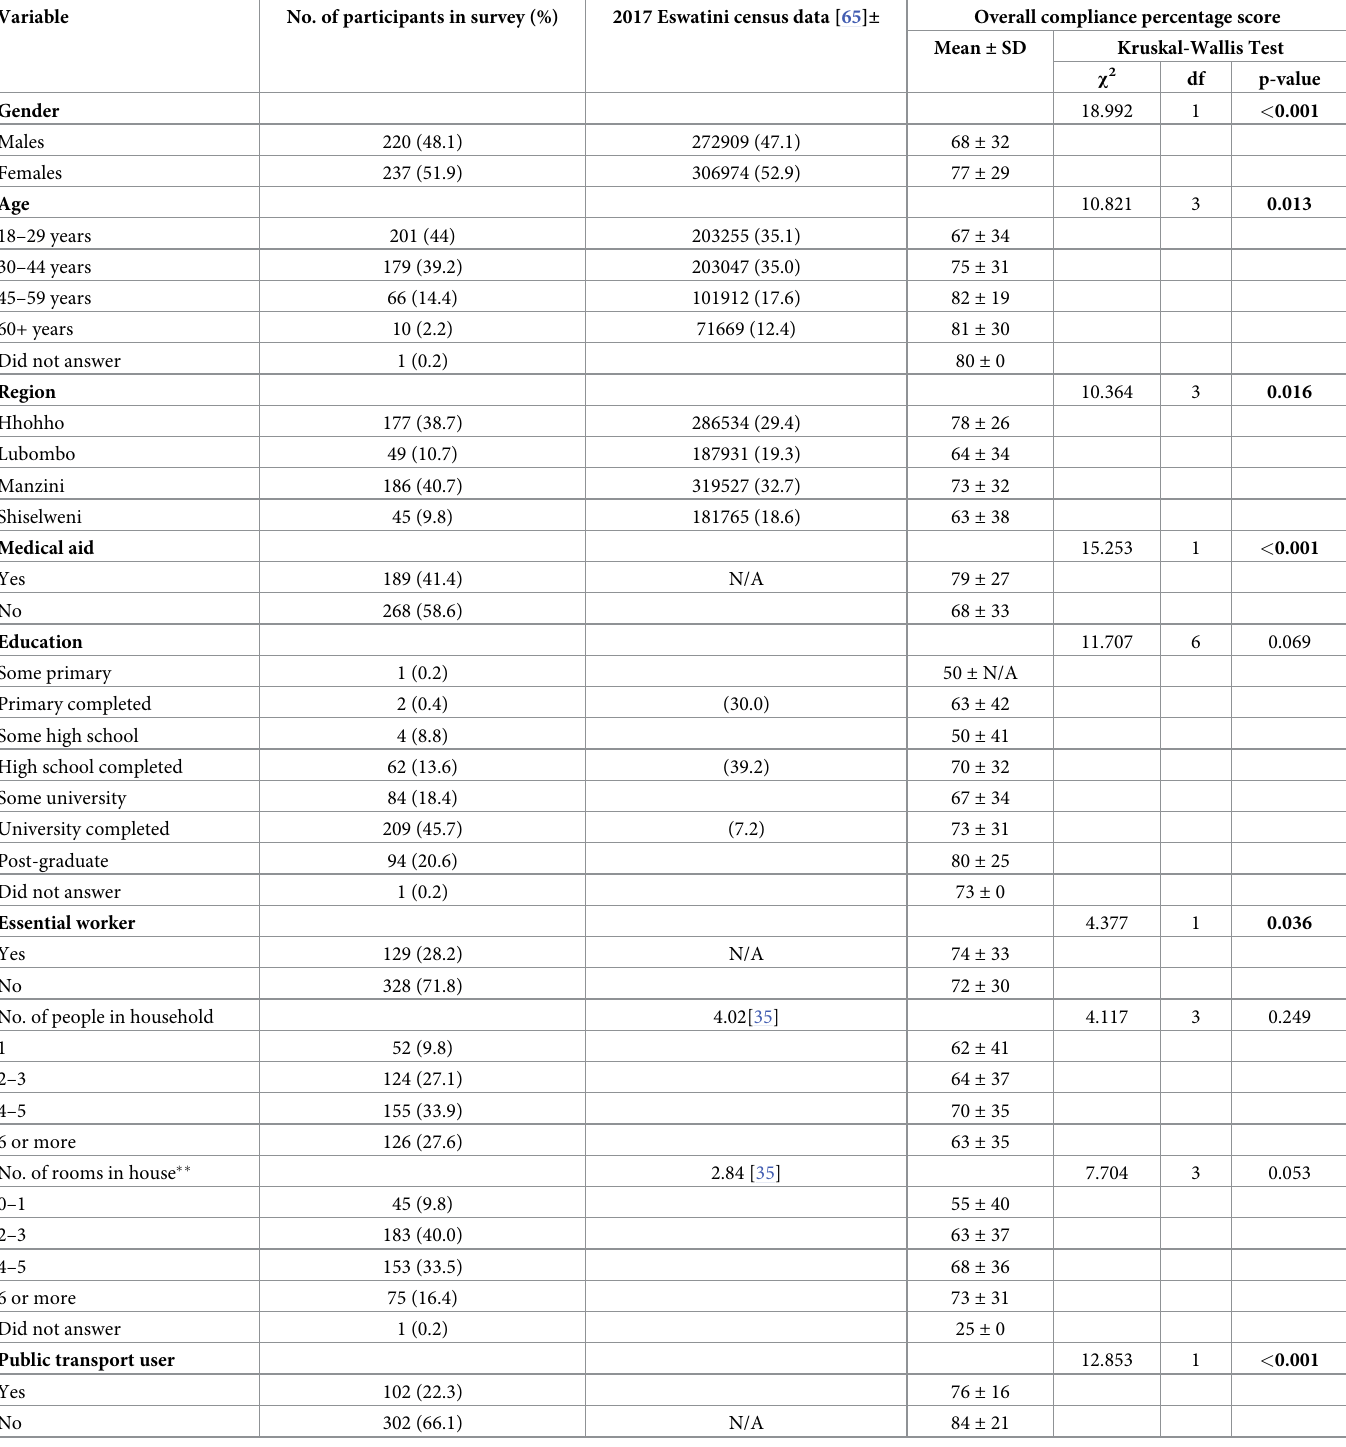
Table 2. Sociodemographic data of survey